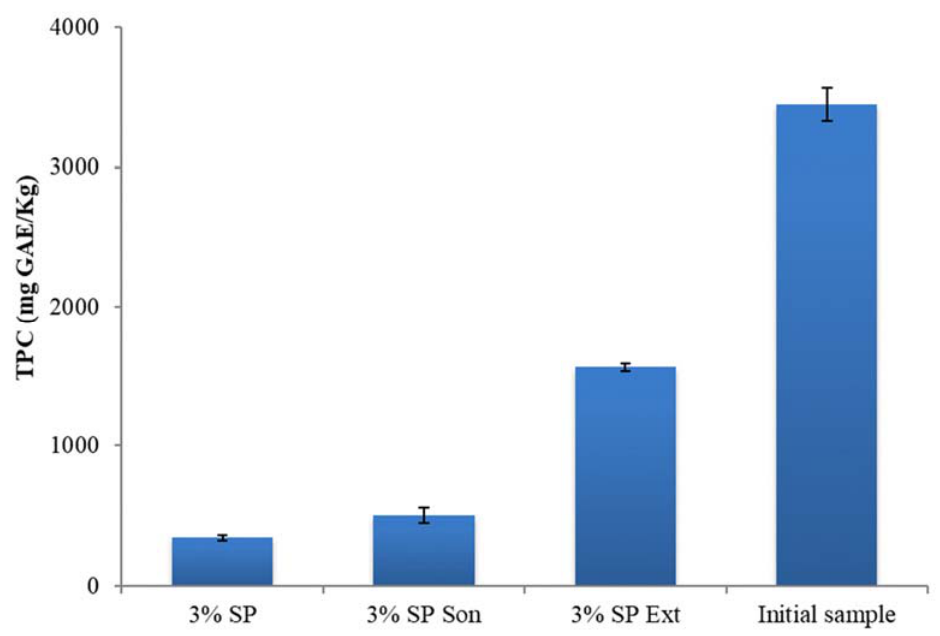
Figure 3. Changes in the concentration of total polyphenols; SP for the Surfactant Phase, and Son for the sonication treatment; Standard deviations are presented with error bars.